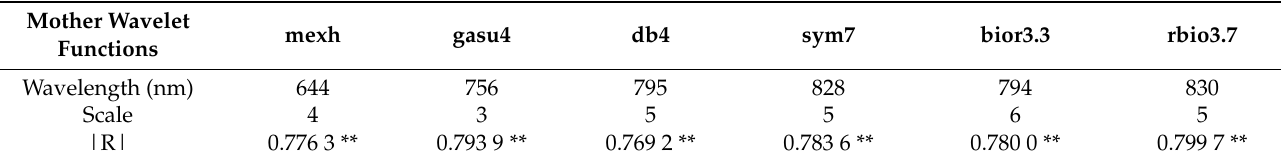
Table 4. |R| of Fv/Fm with